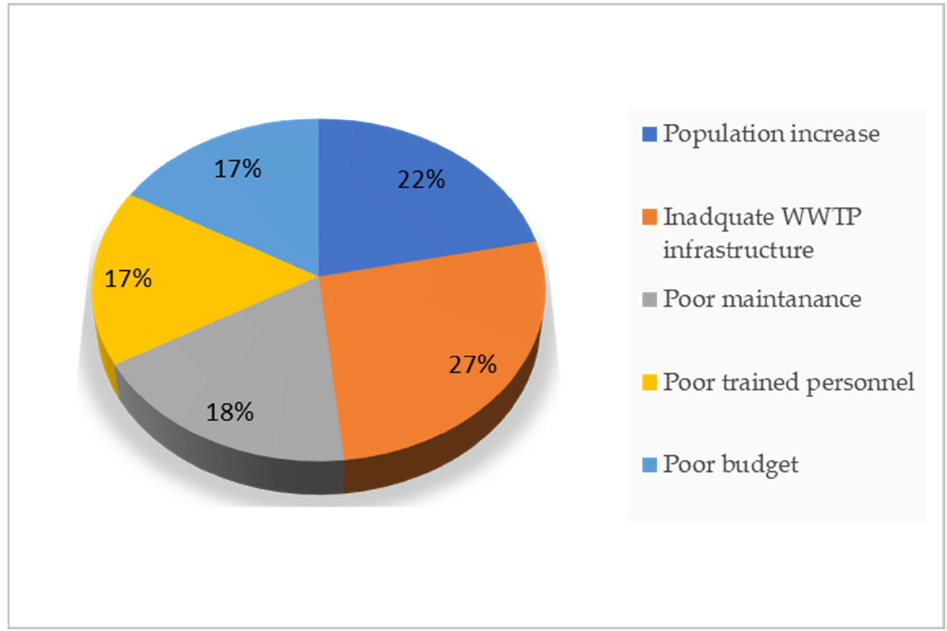
Figure 2. Problems experienced by Bushbuckridge Municipality.